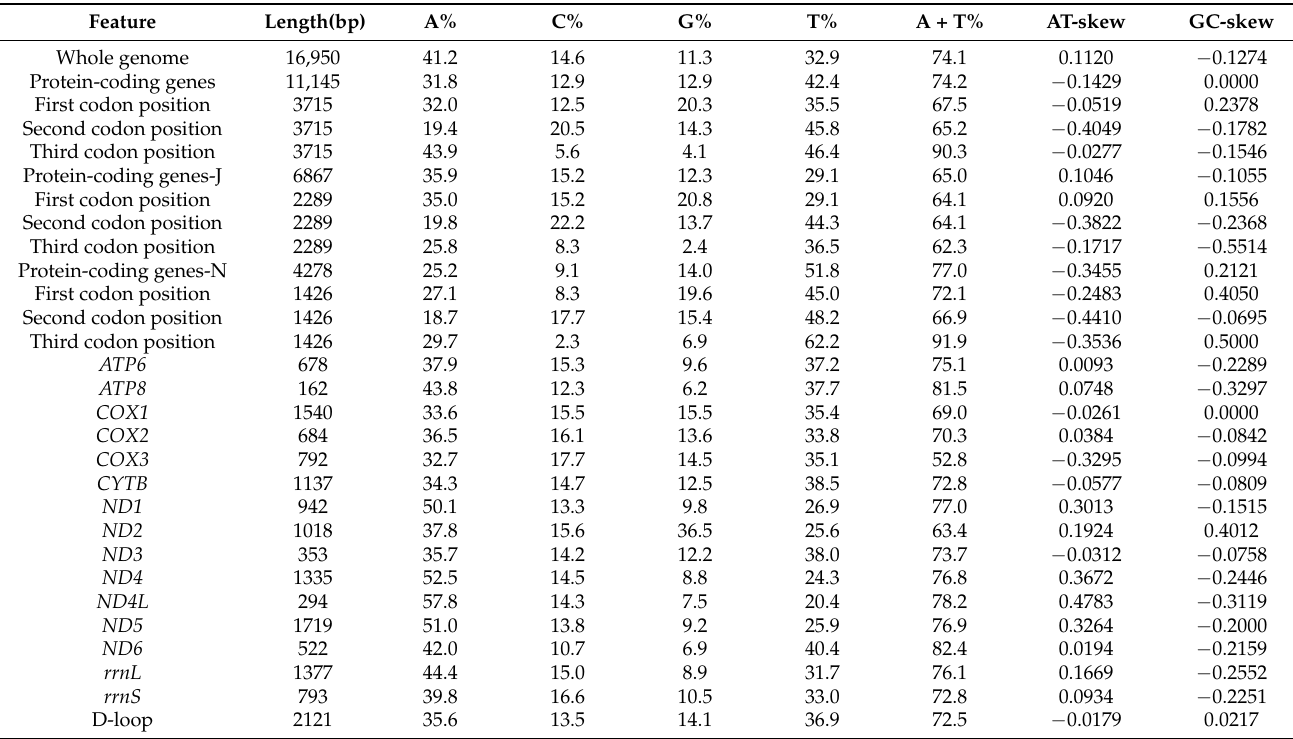
Table 2. Nucleotide composition of the mitogenome of Alulacris shilinensis